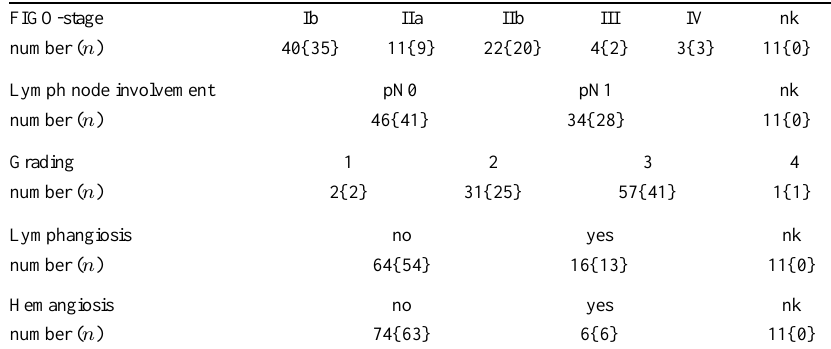
Distribution of clinical-histopathological parameters of patients with primary cervical cancer ( n = 91). Distribution of patients with prospective analysis were documented in brackets { n = 69}